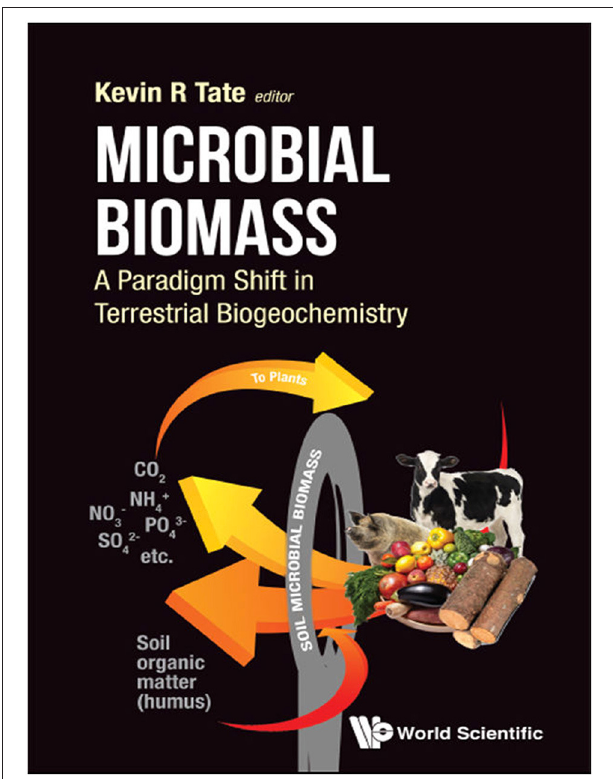
FIGURE 1 | Book cover of Microbial Biomass (Copyright @ 2017 World Scientific, London, United Kingdom. Reprinted with kind permission).